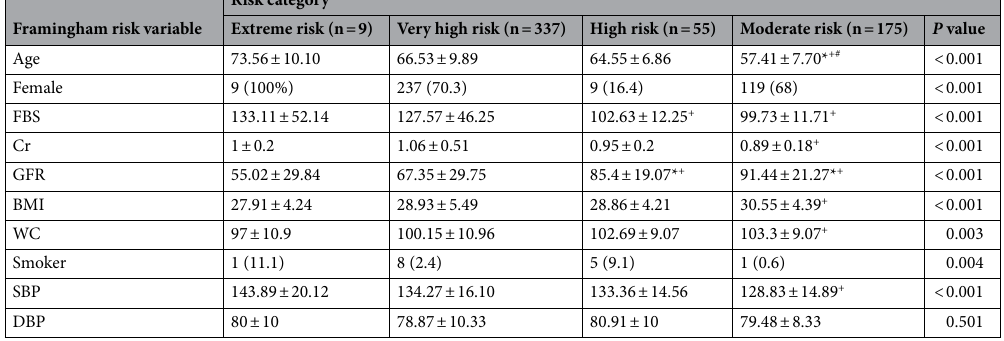
Table 2. Demographic characteristics of 576 patients who treated with statin derivations. Chol total cholesterol, TG triglyceride, FBS fasting blood sugar, BMI body mass index, WC waist circumference, SBP systolic blood pressure, DBP diastolic blood pressure. *Exterme risk versus other groups. + Very high versus other groups. # High versus other